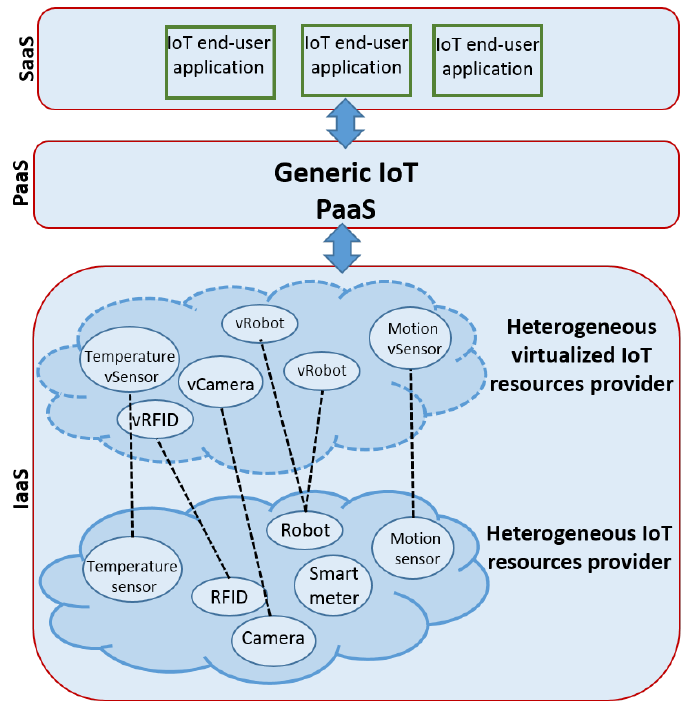
Figure 2. Generic PaaS for whole spectrum of the Internet of Things (IoT)